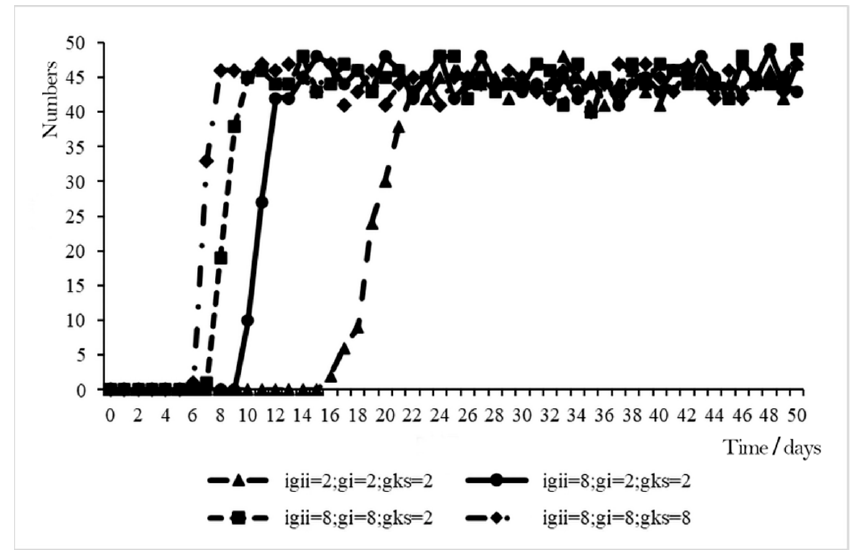
Figure 6. Combined effect of IGII, GI, and GKS on the model. When (IGII, GI, GKS) = (8, 8, 2), the other variables were set as initial values and both workers’ IGII and GI were at high levels. In this scenario, the overall rising tendency of construction workers to engage in safety behaviors was roughly the same as that when IGII = 2. When t = 7, construction workers started to adopt safety behaviors; and from t = 10, the workers who adopted safety behaviors reached a relatively high point with subsequent random fluctuations around that value, while in the scenario of (IGII, GI, GKS) = (8, 8,